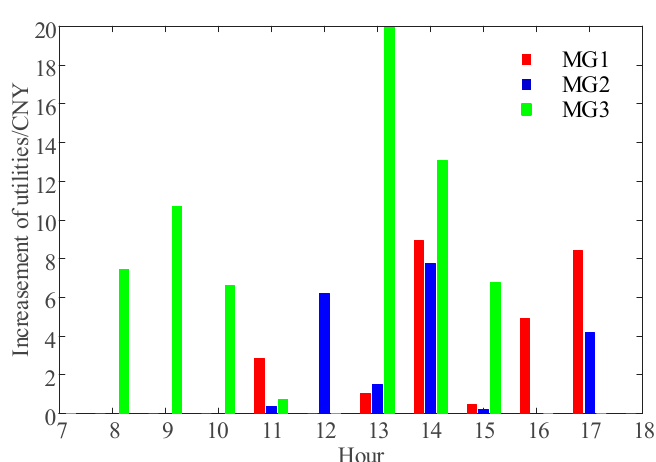
Figure 8. Adjustment of load demands.